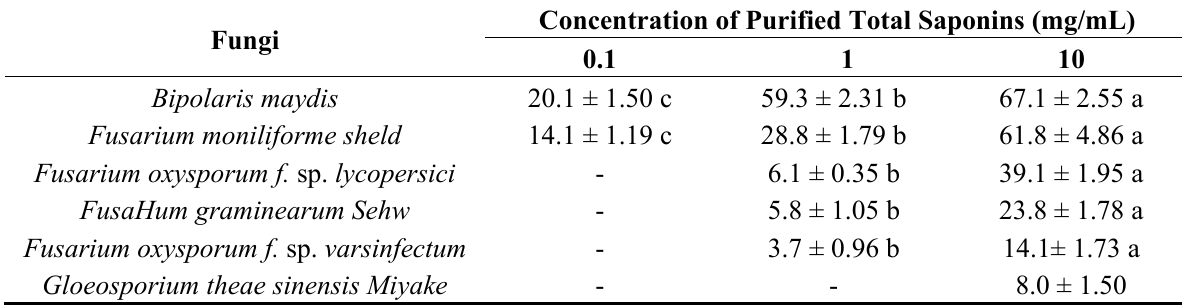
Table 3. Anti-fungal activity of different concentrations of saponins from tea seed pomace on potato dextrose agar plates incubated at 27 °C for 72 h (inhibitory zone diameter: mm). Fungi